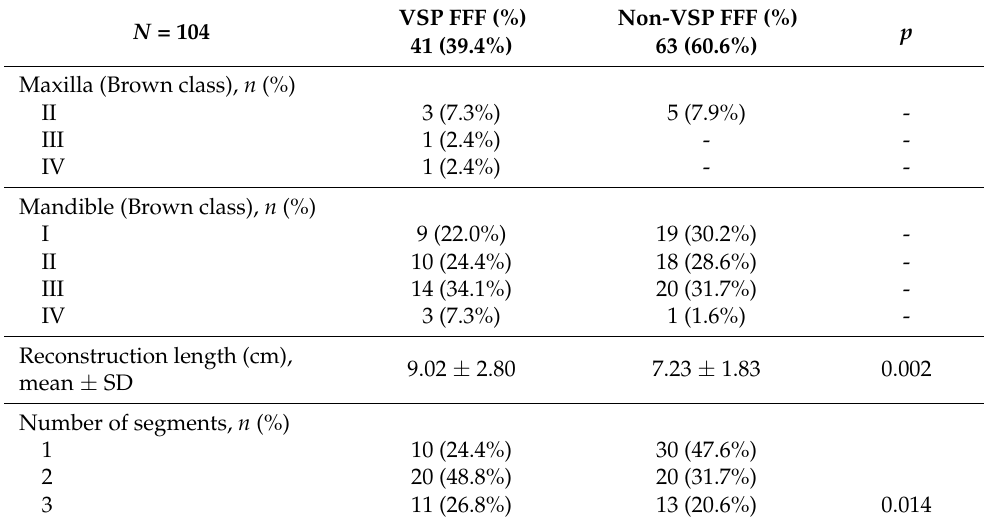
Table 2. Defect and associated FFF parameters of the study groups (VSP, virtual surgical planning; FFF, free fibula flap; SD, standard deviation) [43,44].